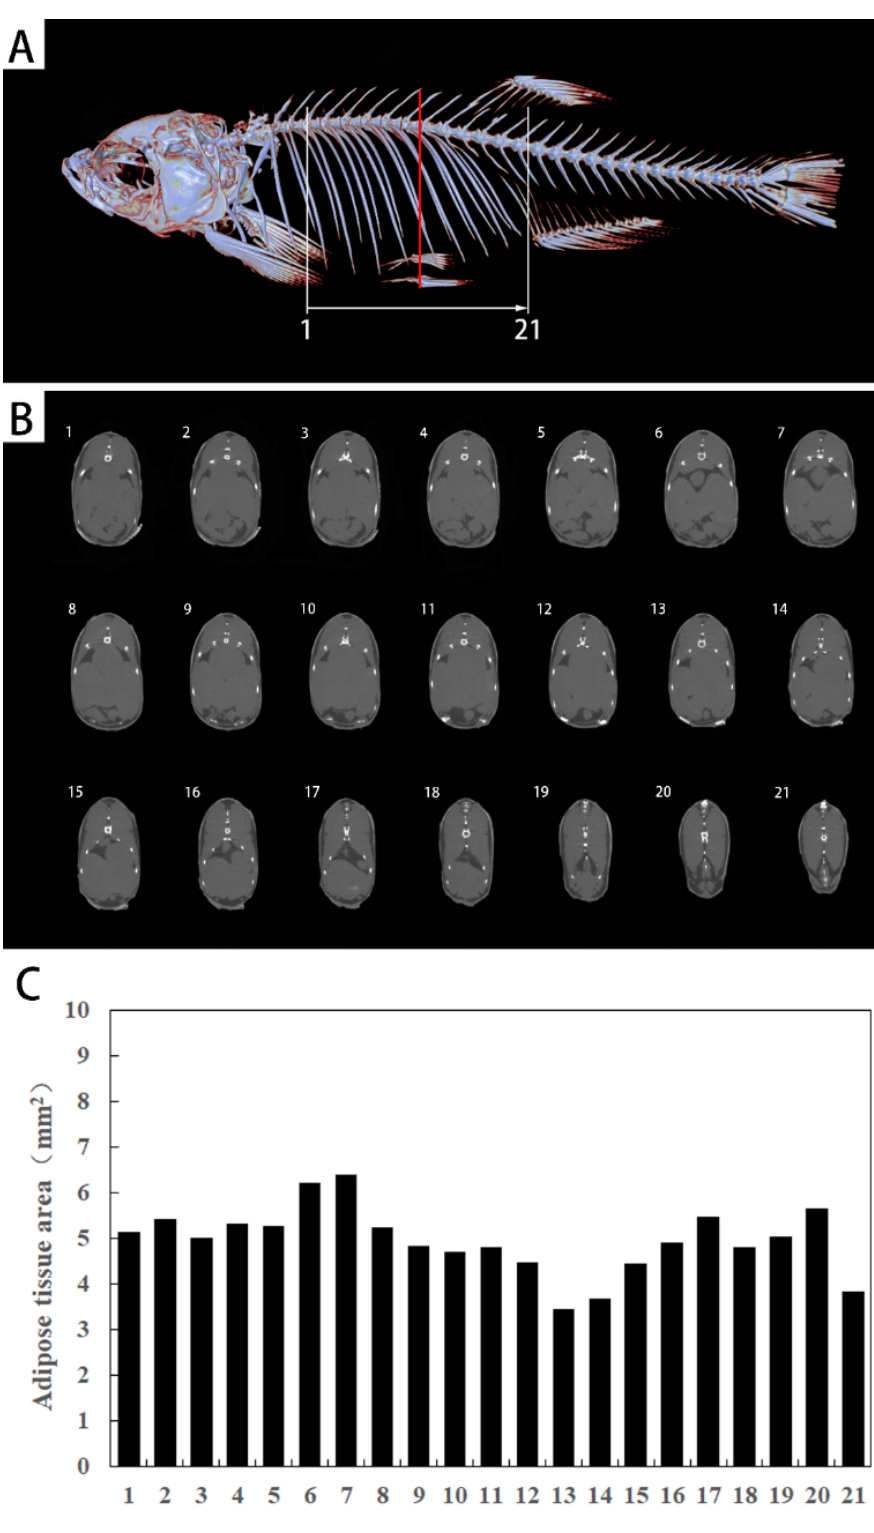
Figure 11. The position of the standard plane for transverse scanning ( A ), a continuous cross-sectional CT scan of adipose tissue of the zebrafish trunk ( B ), and the area of each slice of adipose tissue ( C ).